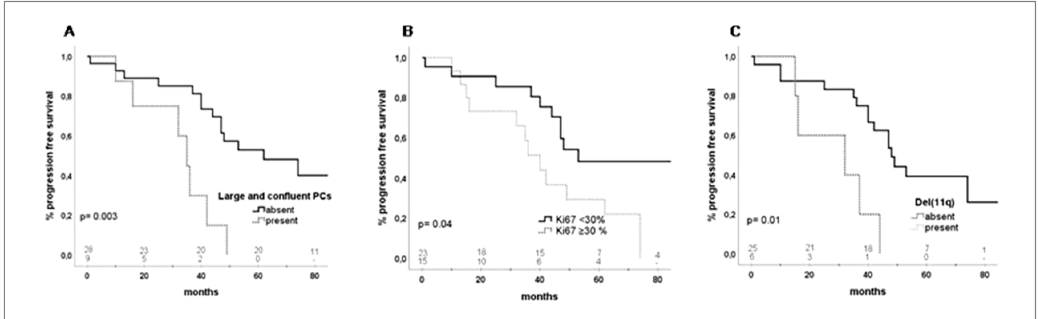
Figure 1. Progression-free survival (PFS) of patients with biopsy-proven CLL. ( A ) Thirty-six-month PFS according to the characteristics of proliferation centers (PCs): patients without large and confluent PCs, 85% (95%CI: 71.4–98.6) vs. with large and confluent PCs, 30% (95%CI: 12–78); p = 0.003. ( B ) Thirty-six-month PFS according to Ki67% expression: patients with Ki67% < 30, 85% (95%CI: 70–100) vs. patients with Ki67% ≥ 30, 51% (95%CI: 25.3–77.3); p = 0.04. ( C ) Thirty-six-month PFS according to deletion (11q): patients without del(11q), 75% (95%CI: 77.6–92.4) vs. patients with del(11q), 40% (95%CI: − 1–81); p = 0.01.